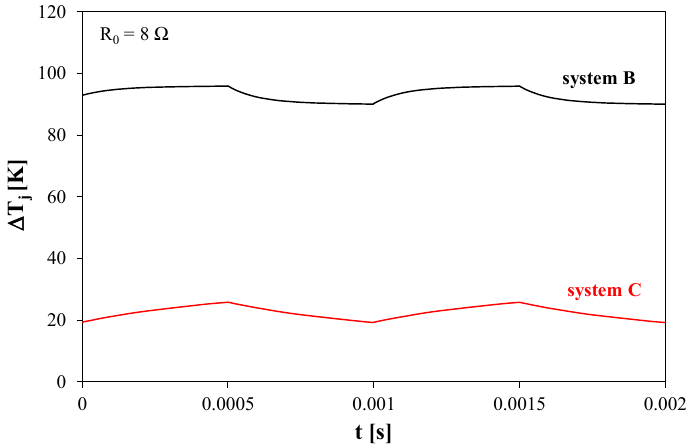
Figure 10. Waveforms of the junction temperature at the steady state for the transistor operating in the switch circuit and cooperating with the cooling systems B and C at frequency f = 1 kHz and load